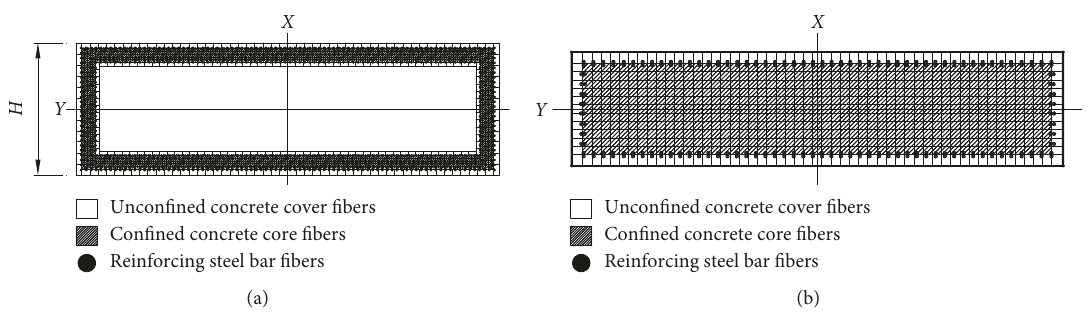
Figure 4: Cross section of the bridge: (a) abutment and (b) pier fiber